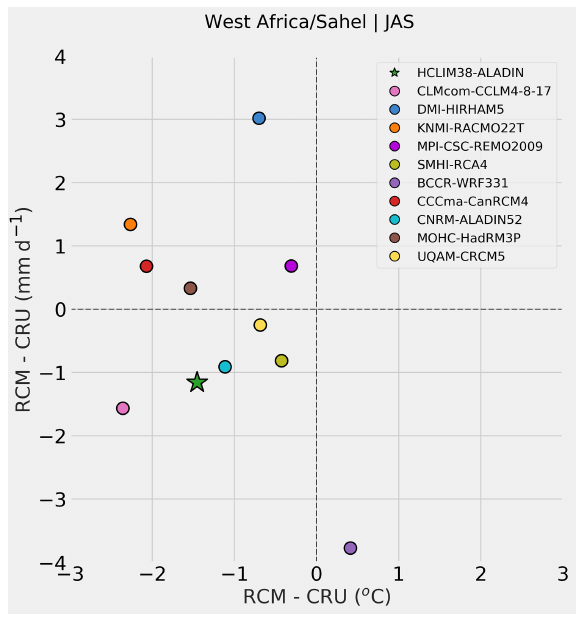
Figure 9. RCM biases (with respect to CRU) in mean July– September (2000–2009) temperature and precipitation over West Africa (7.5–15 ◦ N, 10 ◦ W–10 ◦ E). Circles represent individual RCMs from the CORDEX-Africa ensemble, and the star is HCLIM38-ALADIN. The horizontal resolution is 0.44 ◦ or